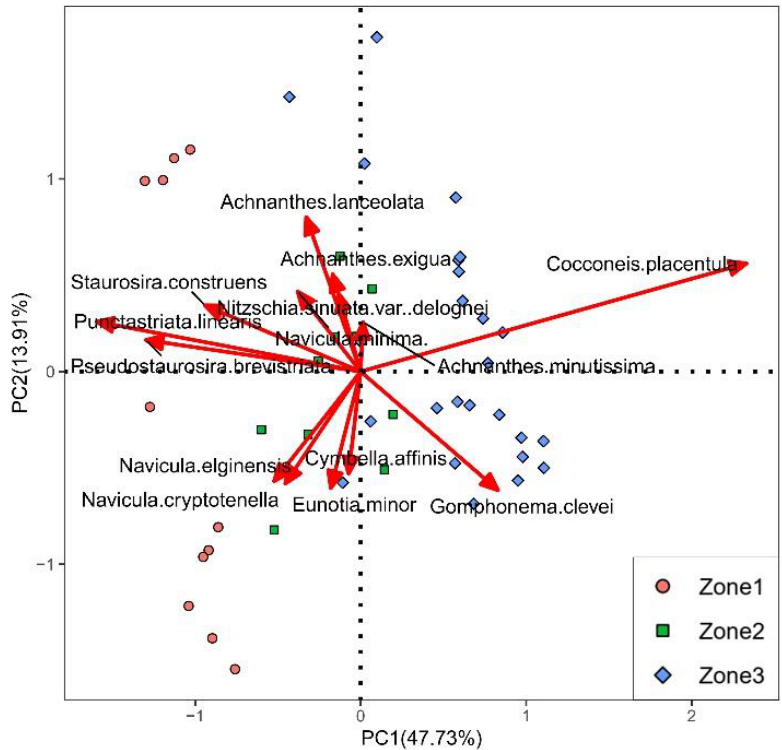
Figure 6. PCA biplot of the dominant diatoms found in sediment from LSP.